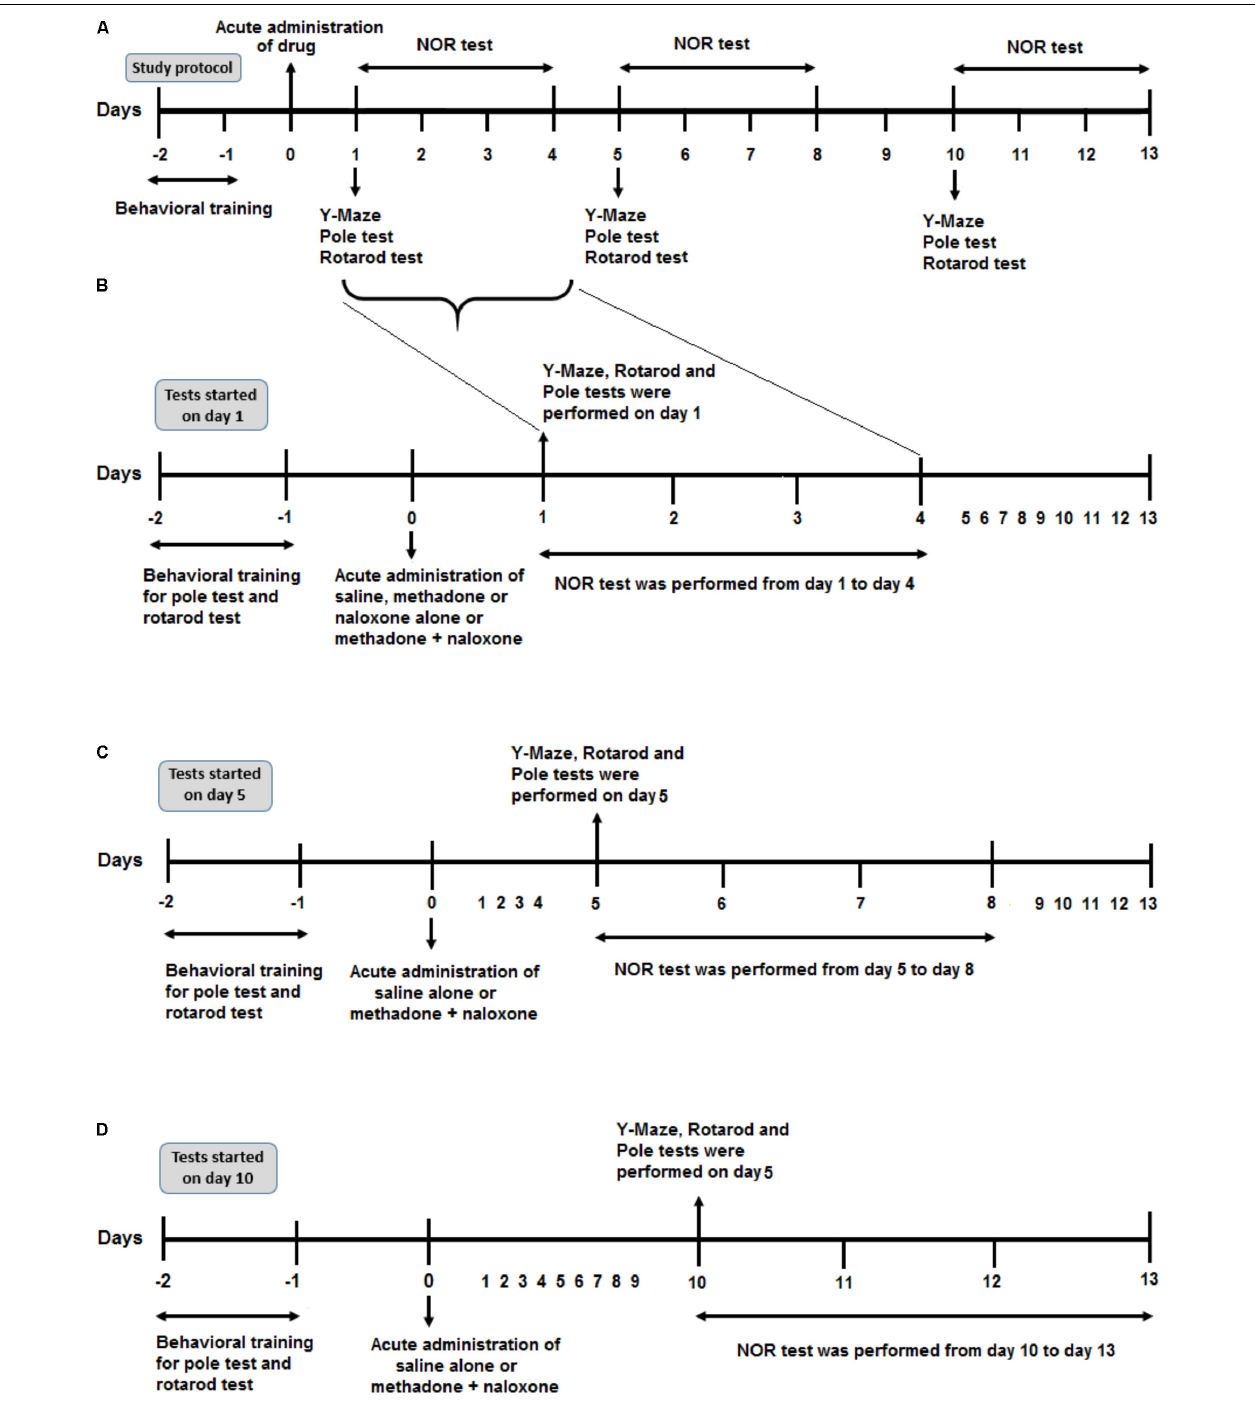
FIGURE 1 | Schematic illustration of the experimental schedule. (A) Protocol overview of the study. After 2 days of behavioral training (rotarod and pole tasks), all rats were administered drug injection on day 0. According to the time of the behavioral test, (starting on day 1, 5, or day 10 after drug administration) they represented here in three parts. (B) After drug application, six separated animal groups (Saline, Methadone, Naloxone, M/N-Sedate, Saline control-Day 1, and M/N-Day 1) were used to evaluate different behavioral tests including Y-Maze, Rotarod test and Pole test on day 1 after drug administration and Novel object recognition (NOR) test from day 1 to day 4 post-treatment. (C) In two other separated groups (Saline control-Day 5, M/N-Day 5), after administration of saline alone or methadone + naloxone on day 0, Y-Maze, Pole test, and Rotarod test were carried out on day 5 followed by NOR test from day 5 to day 8. (D) In Saline control-Day 10 and M/N-Day 10 groups, 10 days after administration of saline alone or methadone + naloxone, Y-Maze, Pole test and Rotarod test were carried out on day 10 followed by NOR test from day 10 to day 13.